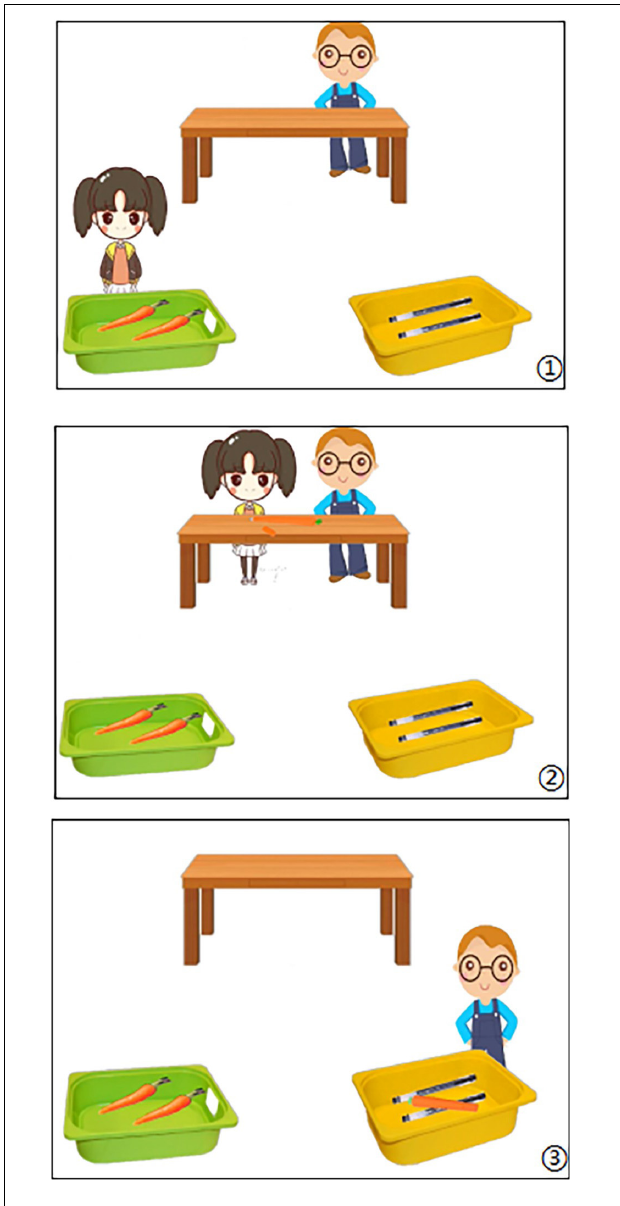
FIGURE 1 | Example for cognitive verb training.